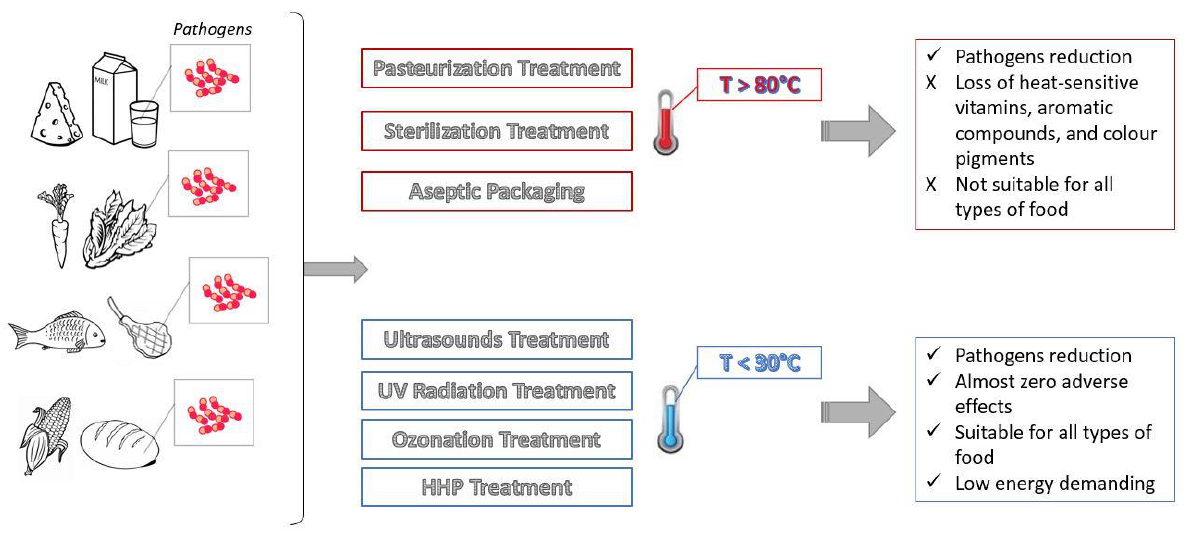
Figure 1. General aspects of thermal and non-thermal techniques.